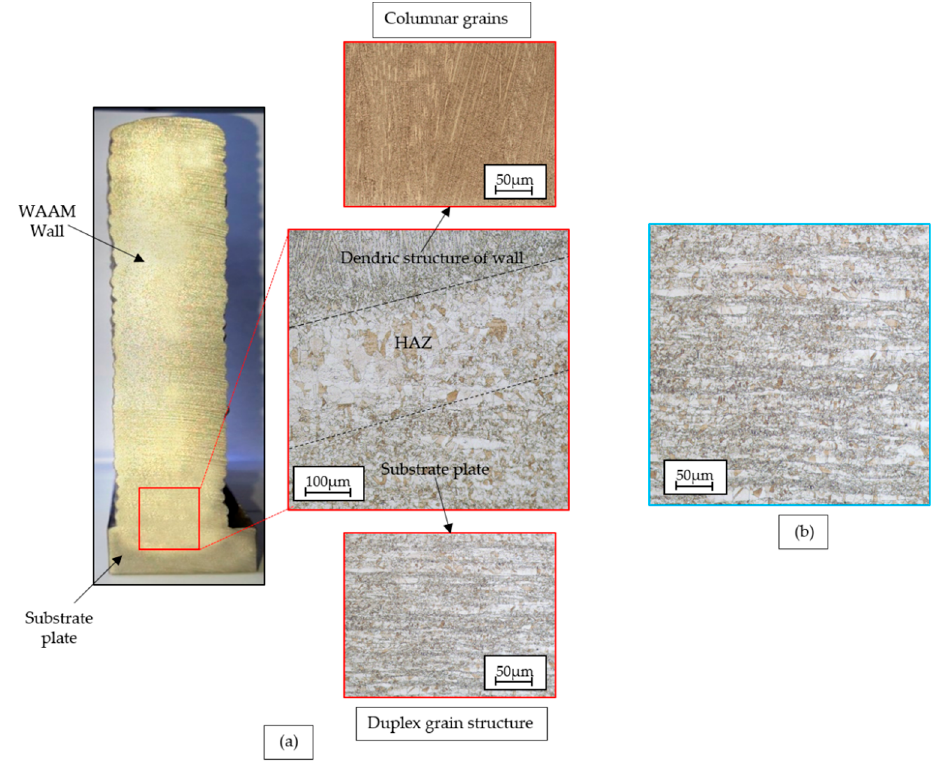
Figure 4. ( a ) The representation of the WAAM wall and its typical microstructure ( b ) wrought IN718 by using optical microscopy.